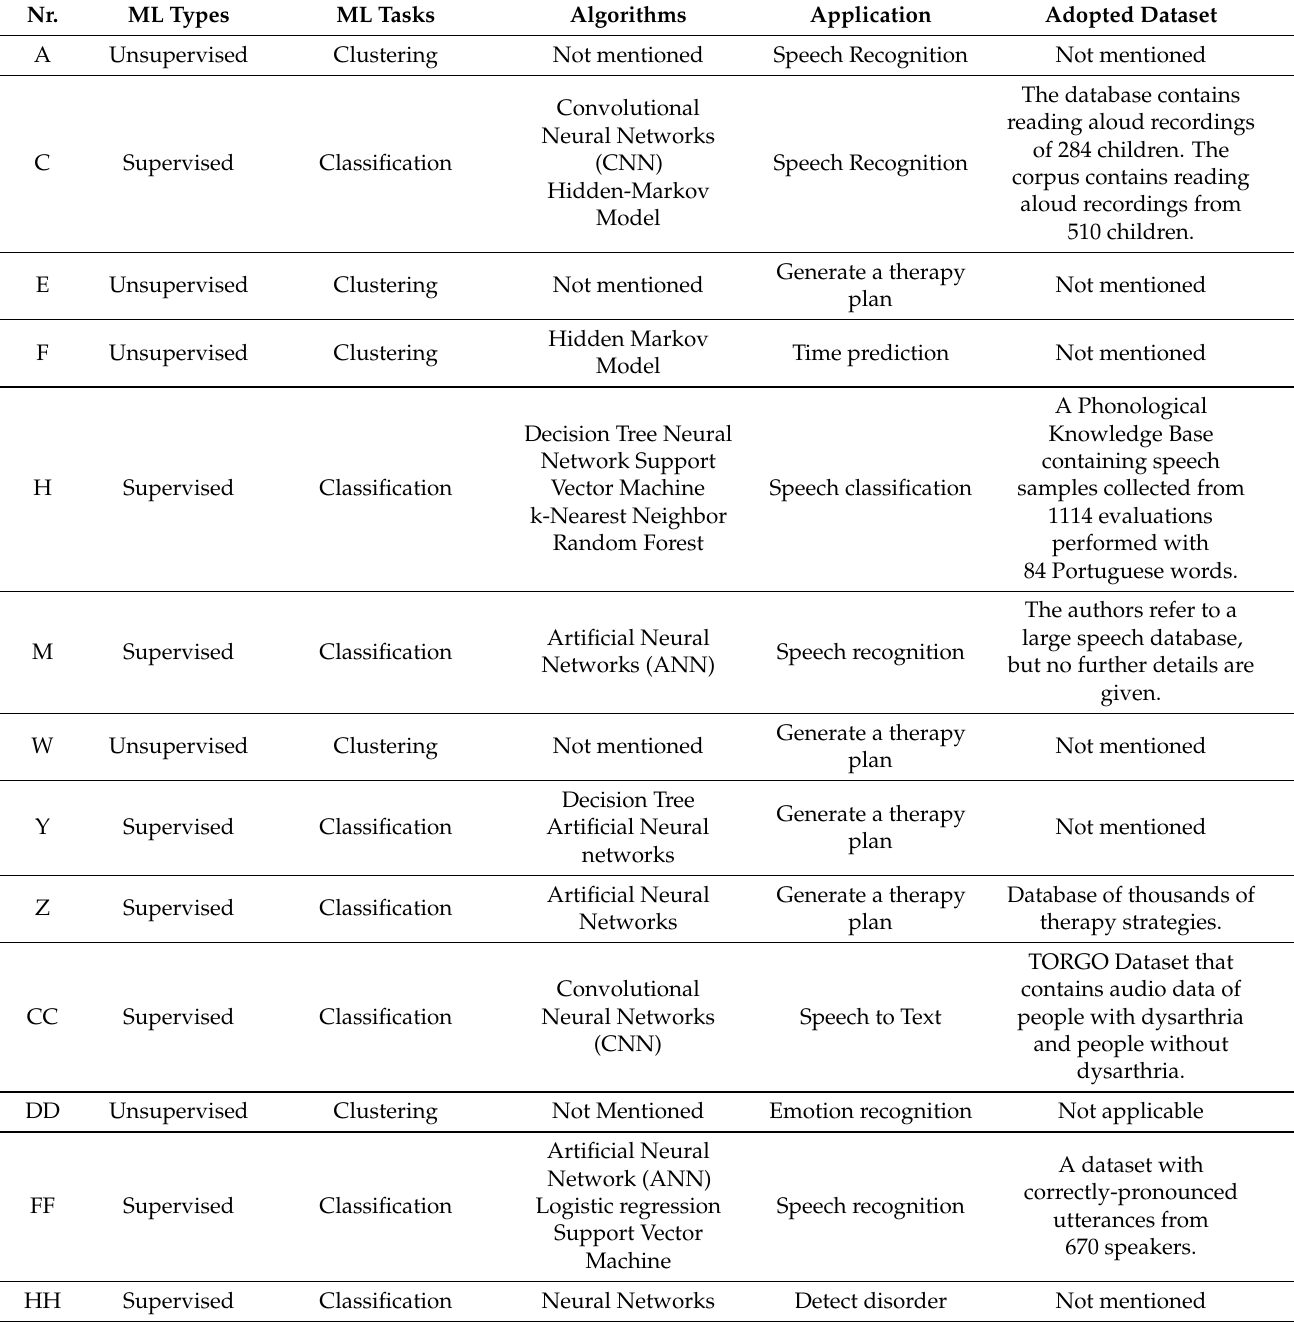
Table 8. Overview of adopted ML